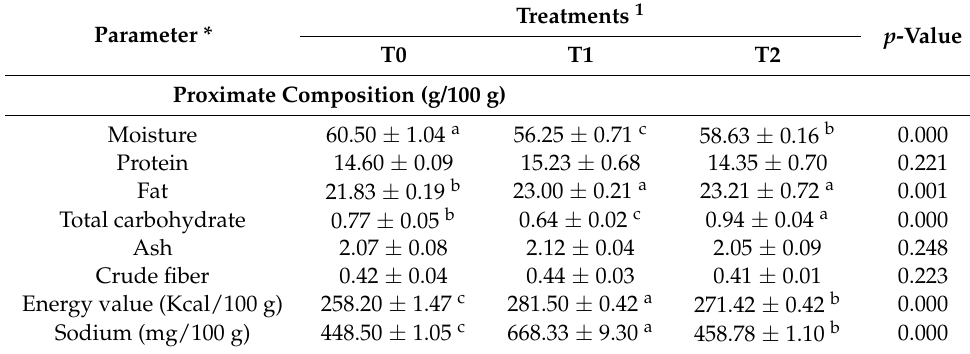
Table 3. Energy value and proximate composition of